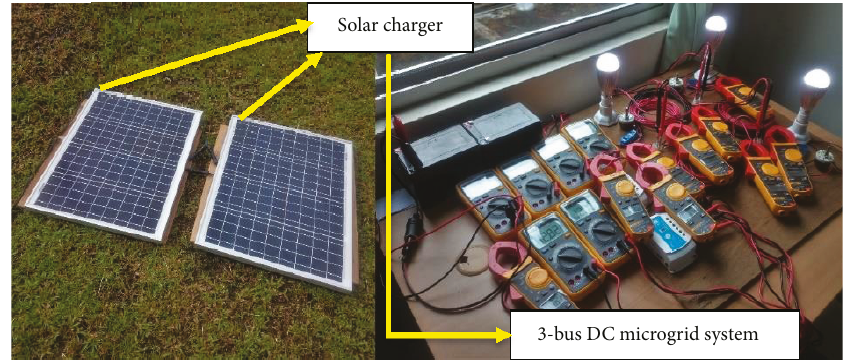
Figure 8: Experimental setup for the single-source con fi guration.